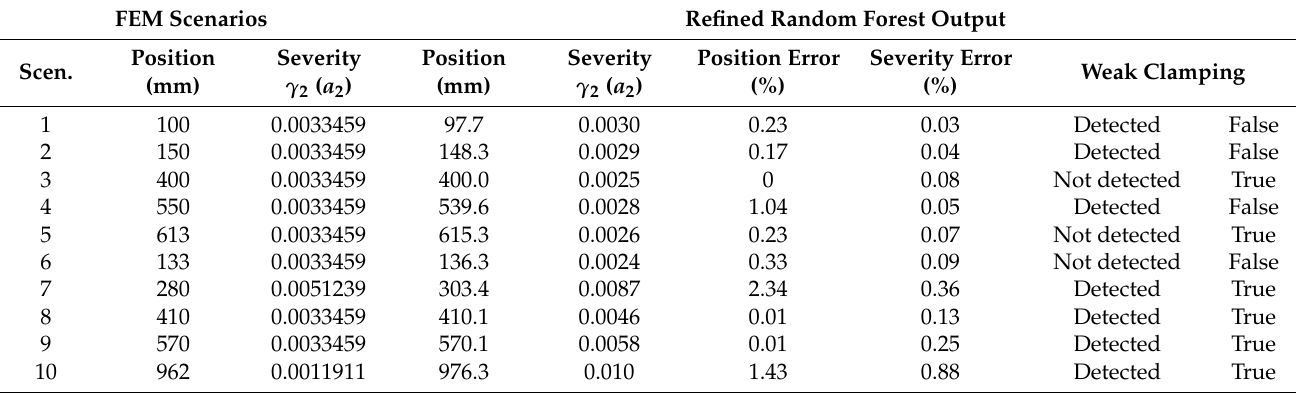
Table 6. Results obtained using Random forest enhanced model—second step.